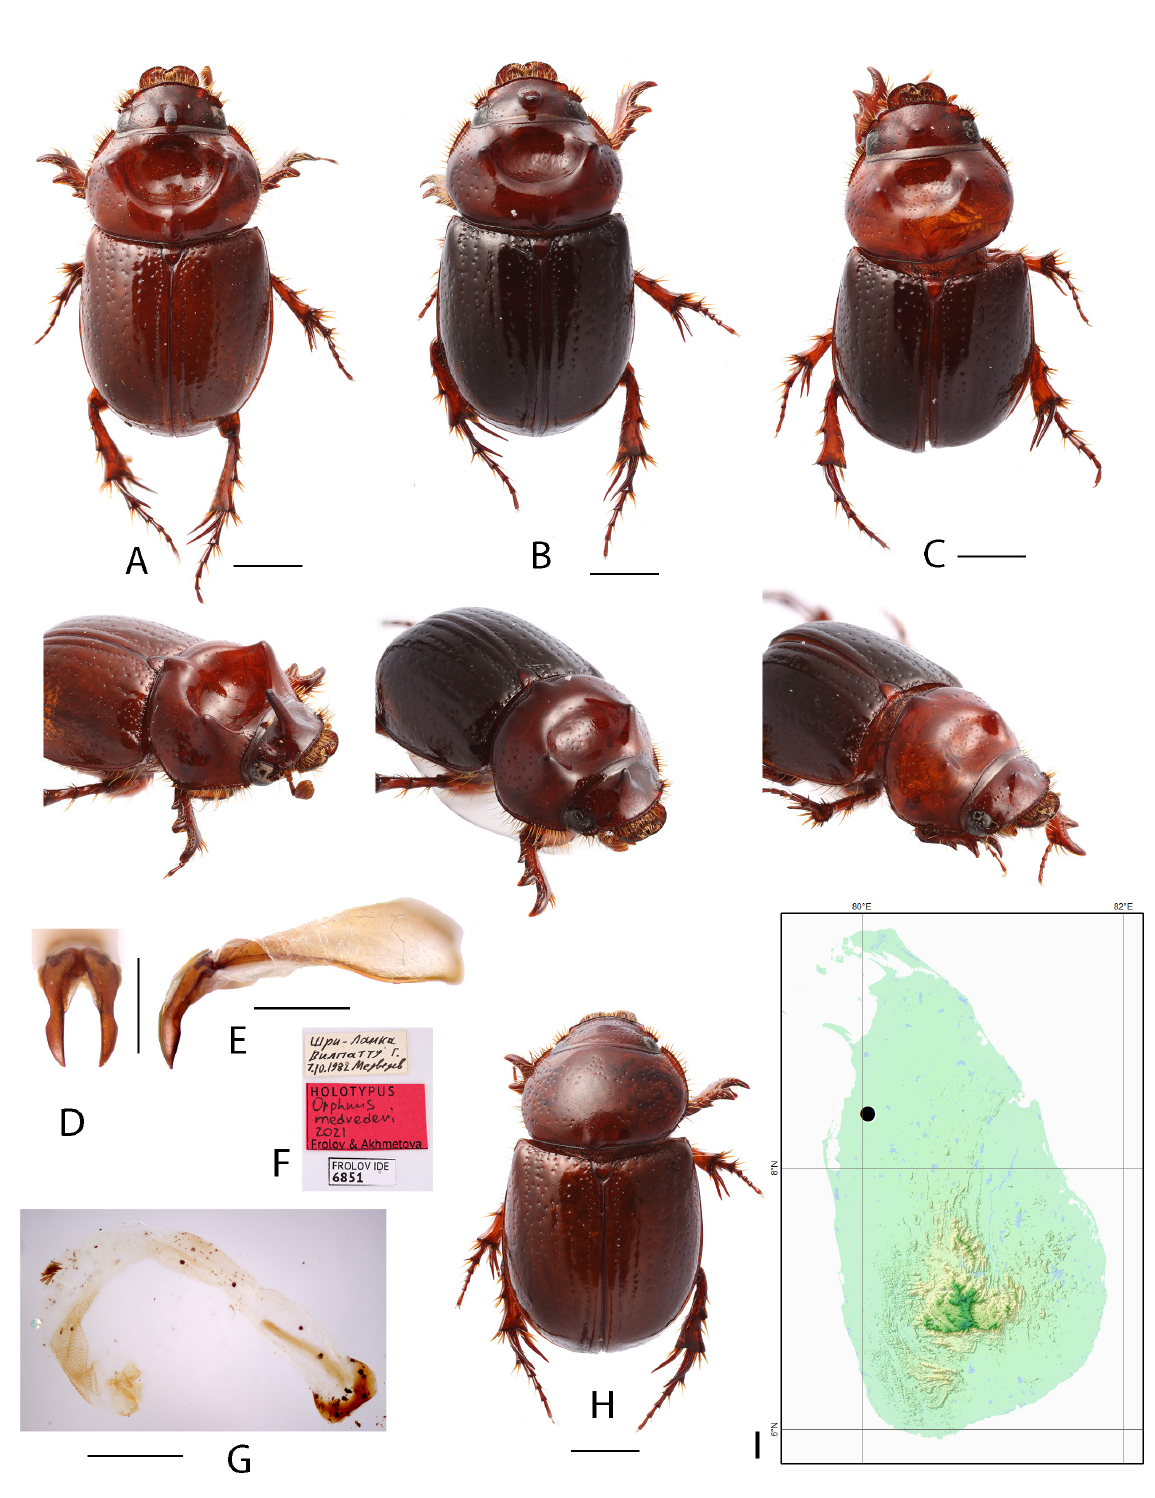
Fig. 3. Orphnus medvedevi sp. nov. A , D–G . Holotype, ♂ (ZIN). B–C . Paratypes, ♂ (ZIN). H . Paratype, ♀ (ZIN). A–C , H . Habitus in dorsal view. D . Parameres in dorsal view. E . Aedeagus in lateral view. F . Labels. G . Endophallus. I . Distributional record map. Scale bars: A–C, H = 1.0 mm; D–E, G = 0.5